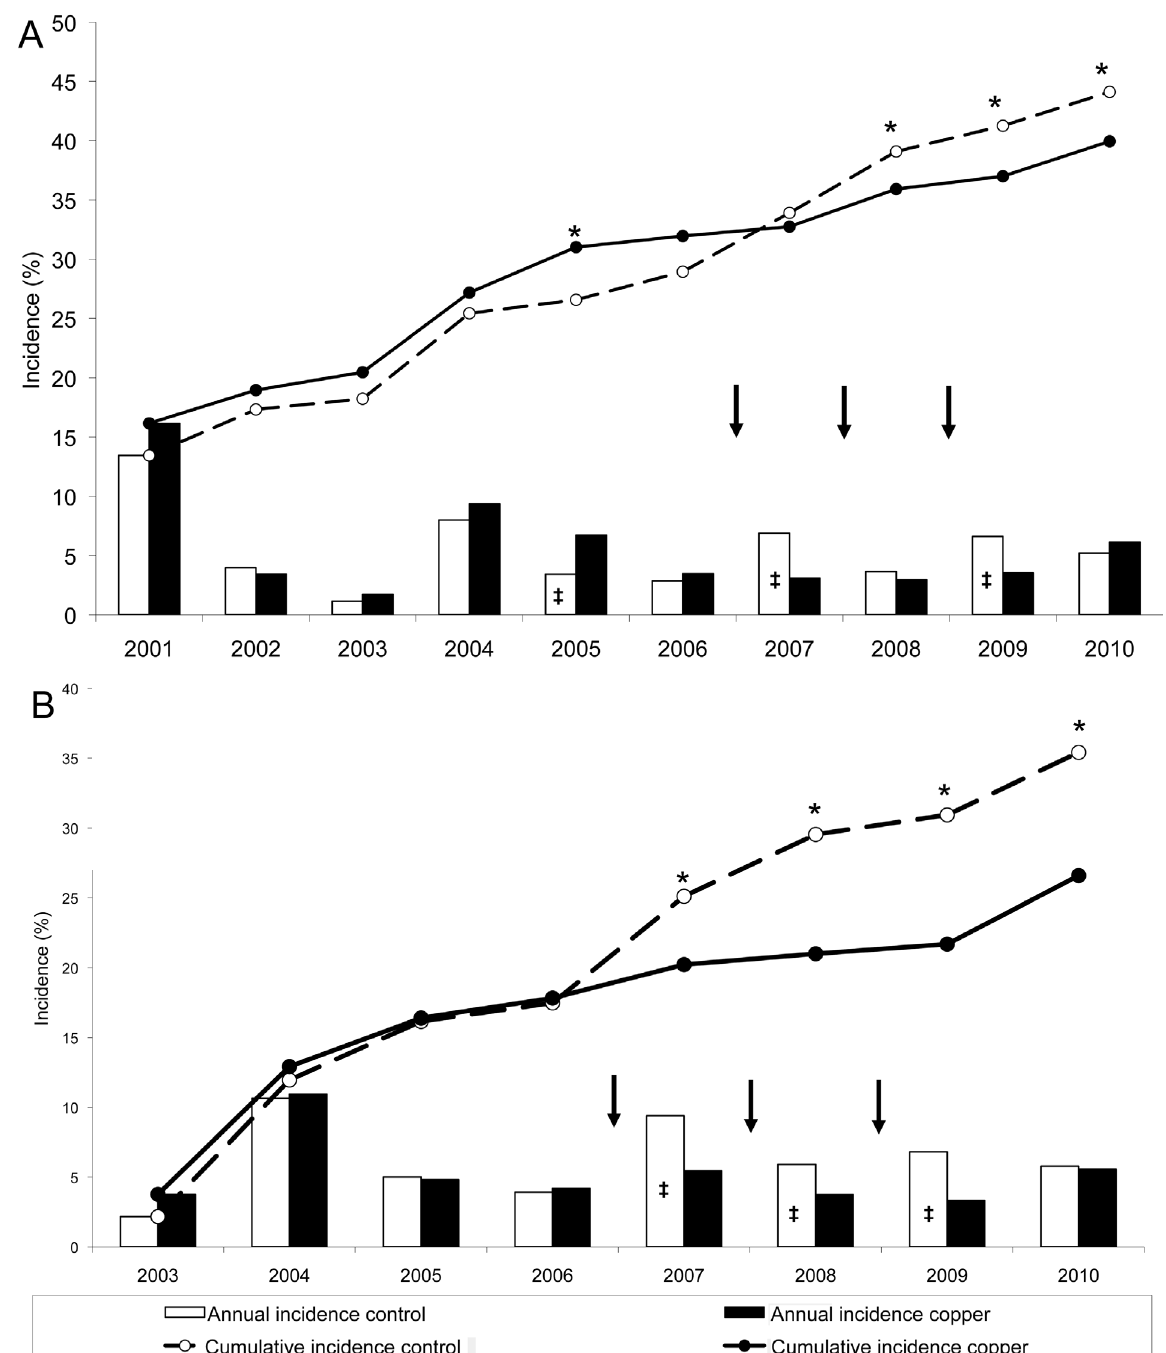
Figure 2. Effects of applications of the copper formulation on vineyards cv. Pignoletto (A) and Riesling (B). For each year of assessment, values of annual tiger stripe symptoms incidence (bar) or cumulative incidence (line) marked with * (cumulative incidence) or with (annual incidence), differ significantly according to Chi–Square test ( P <0.05). Ar- rows indicates the years in which the applications were